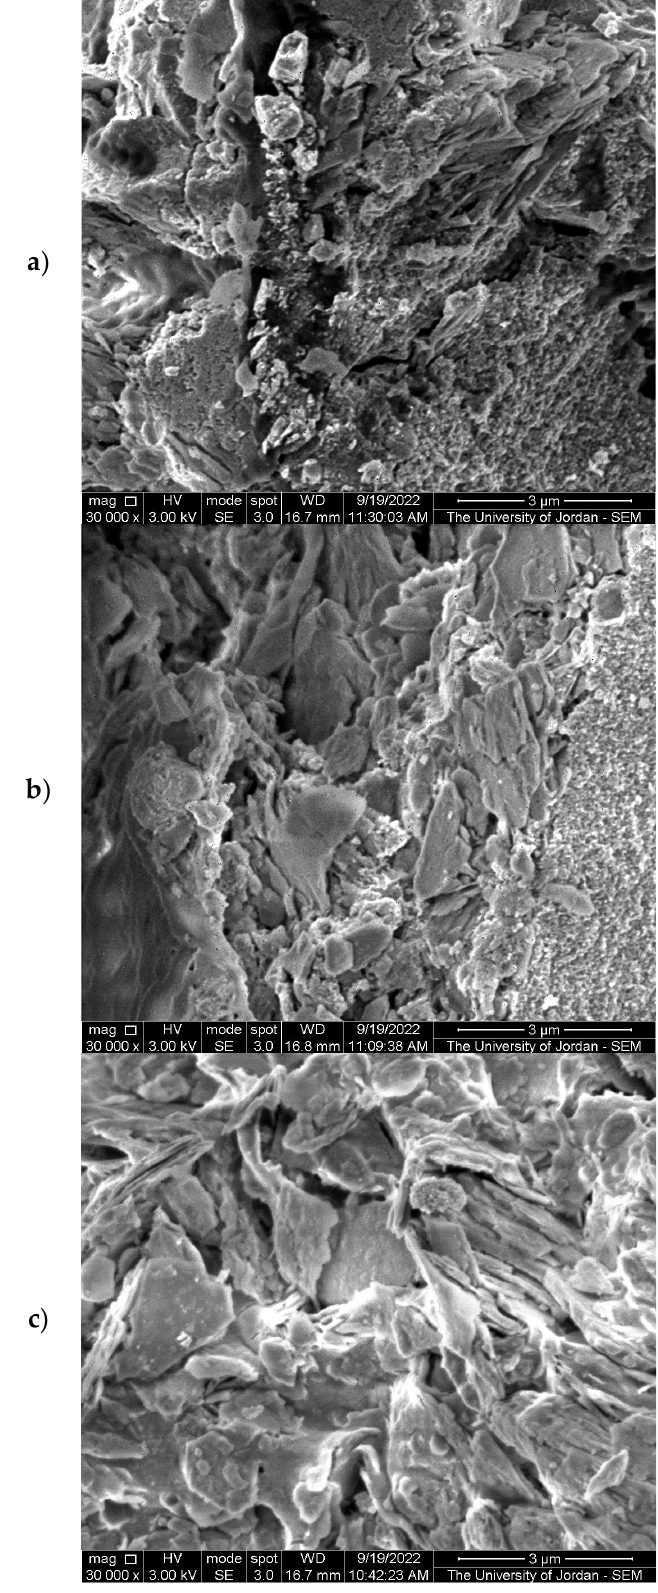
Figure 1. SEM images of ( a ) 60% TiO 2 –JK NC, ( b ) 30% TiO 2 –JK NC, and ( c ) 20% TiO 2 –JK NC. Pure kaolinite has a composition of Al 2 O 3 (39.5%), SiO 2 (46.5%), and structural water (14.0%). Above 400 °C, kaolinite loses the structural OH [15]. It is inert and can be used in industry over a pH range between 3 and 9 [17]. The most important commercial varieties are China clay, ball clay, refractory clay, and flint clay [17]. Kaolinite is used in various industries as paper filling and coating, ceramics, and fiberglass, as well as in cement, re ‐ fractories, plastics, rubber, paint, geopolymers, cosmetics, polymers, and various catalysts